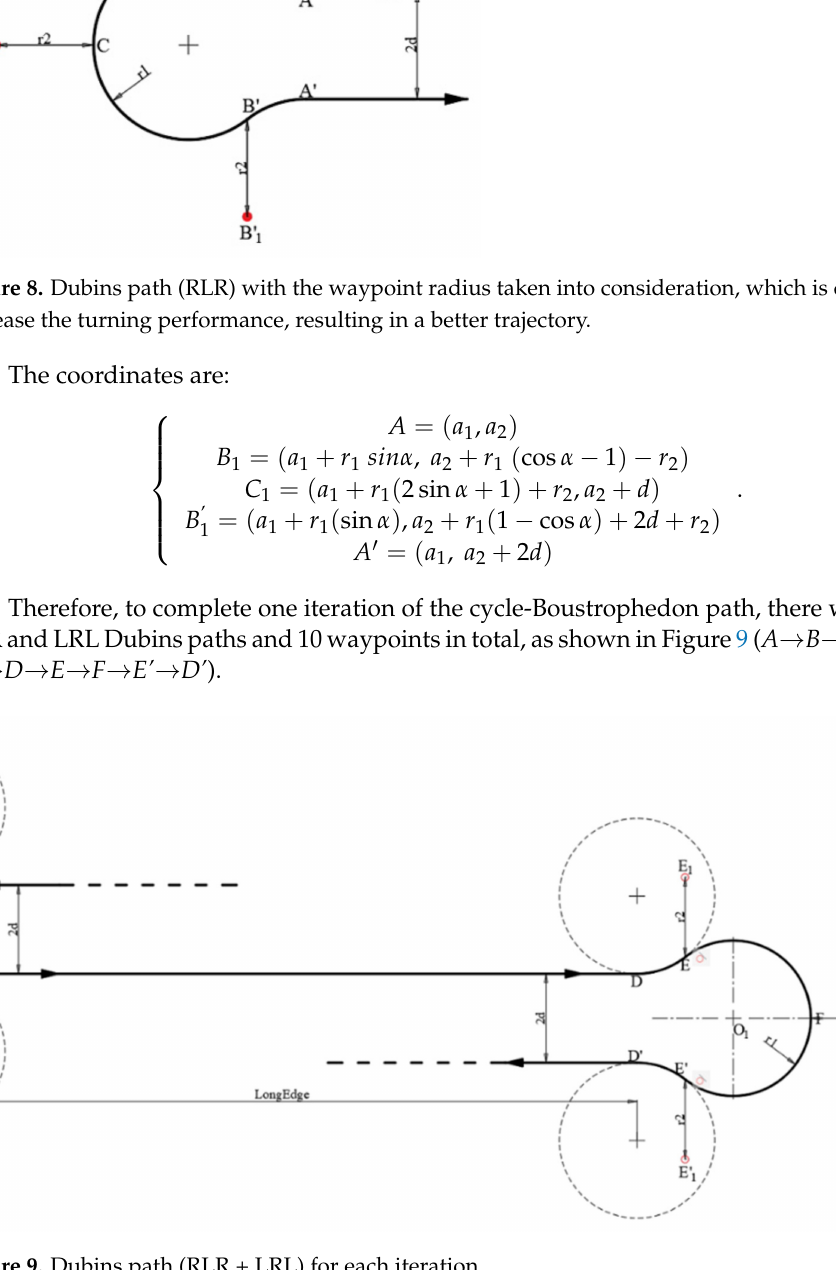
Figure 9. Dubins path (RLR + LRL) for each